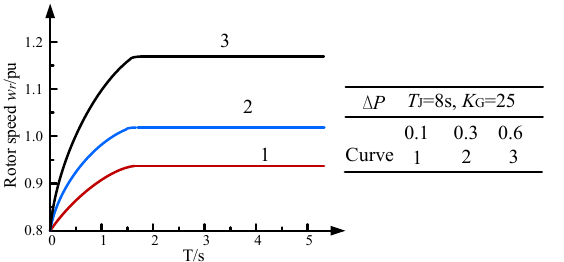
Figure 15. Transient speed ‐ change process of doubly fed induction generator with T J = 8 s, K G = 25,